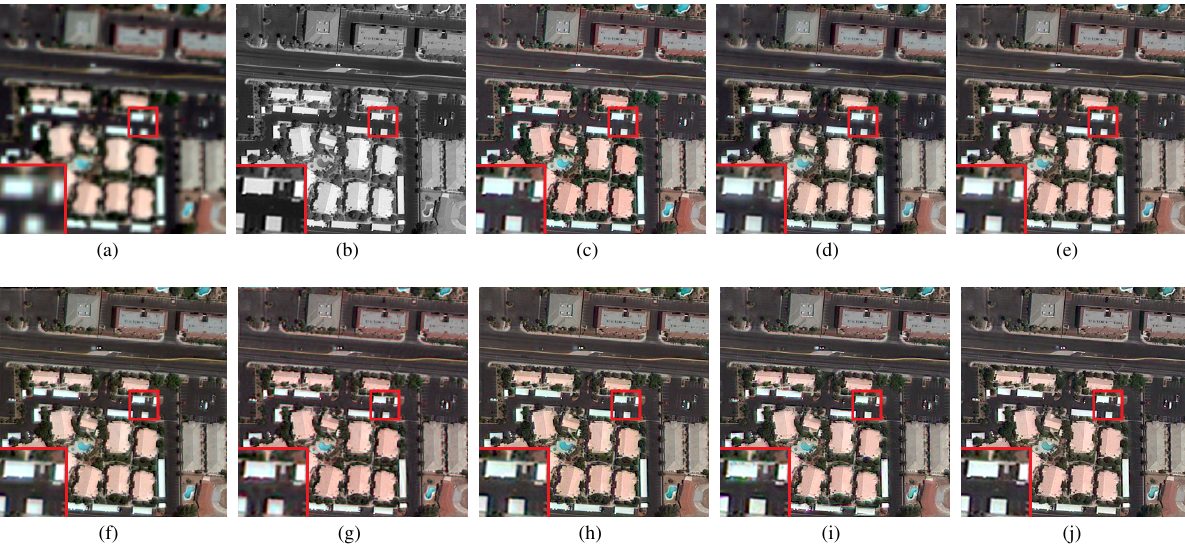
Figure 6. Comparison of pan-sharpening results obtained by different methods (full-resolution). (a) Low-resolution MS image. (b) PAN image. (c-j) Pan-sharpening results of BDSD, MMP, MTF-GLP, GLP-SEGM, PNN, MSDCNN, CSN, and